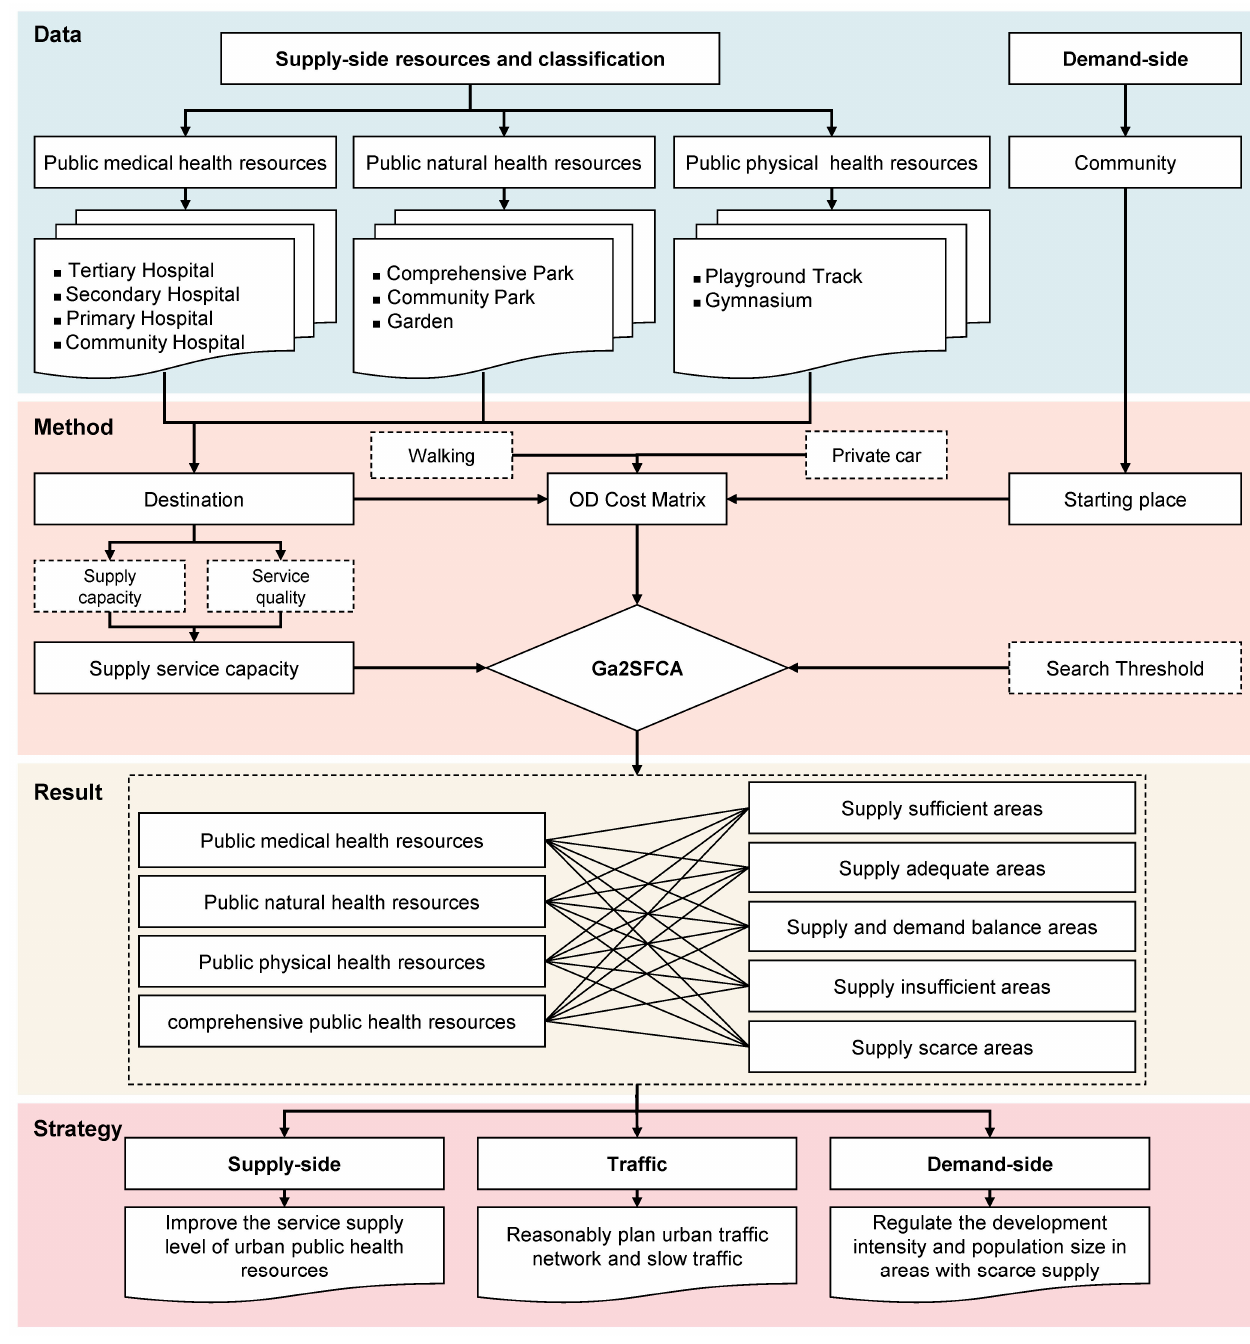
Figure 6. The framework of this